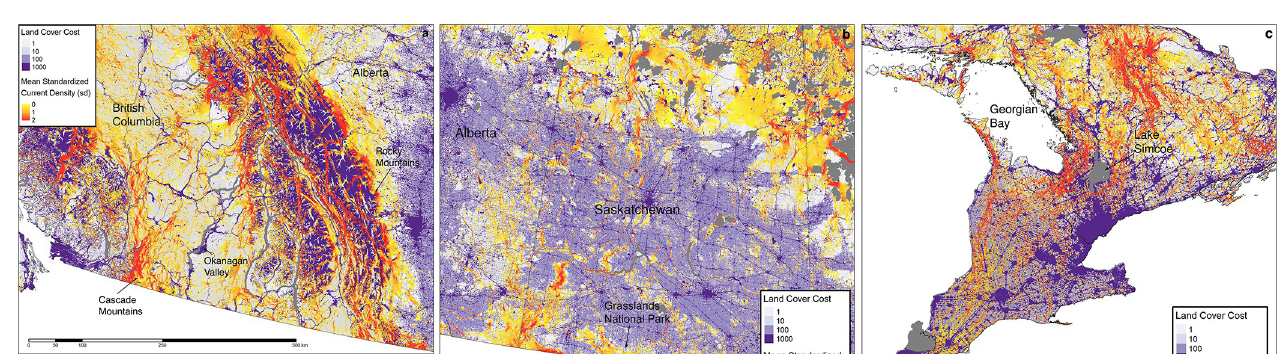
Fig 4. Vignettes of three priority regions for species at risk and biodiversity in Canada. Vignettes display a) southern British Columbia, b) southern Saskatchewan, and c) southern Ontario. Only current densities above the mean are displayed over the movement cost layer. Contains information licensed under the Open Government